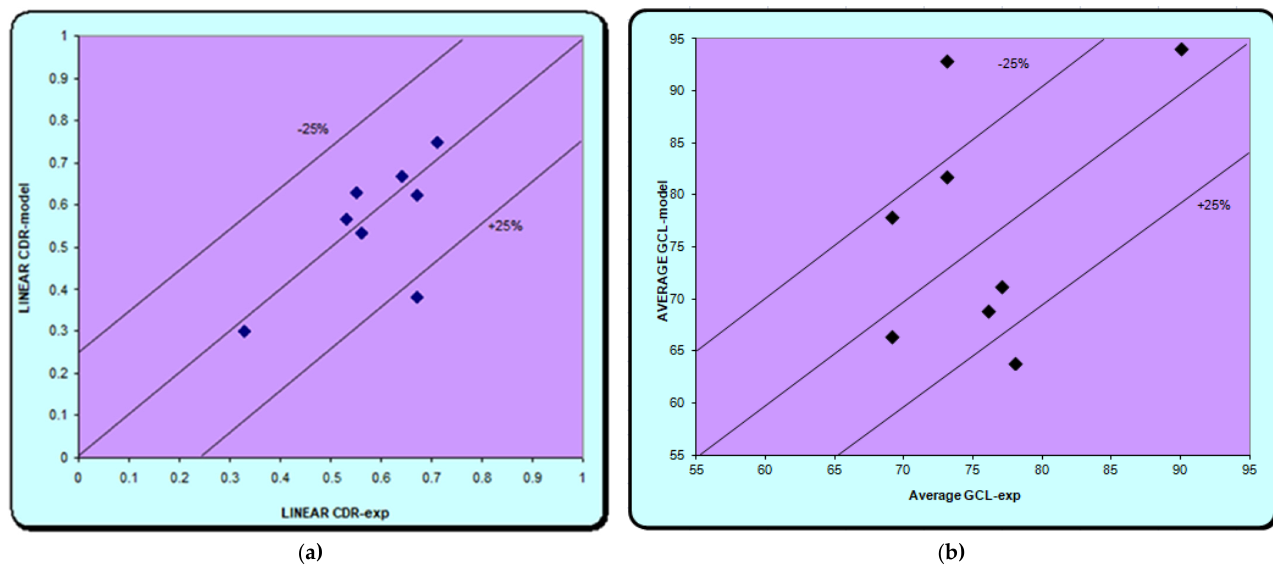
Figure 6. Comparison of experimental results with those provided by the ANN network (21:35:4) in the validation stage ( a ) (experimental c/d); ( b ) (average GCL). The positioning of the points near the center line indicates a very good correlation.